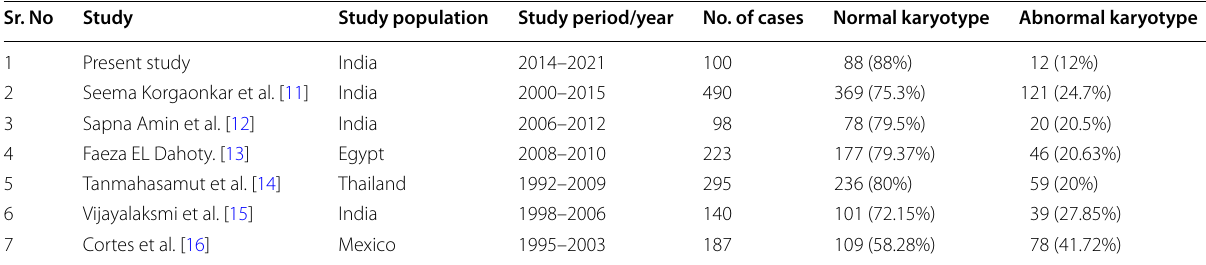
Table 6 Scenario of genetic abnormalities reported in earlier studies of PA cases